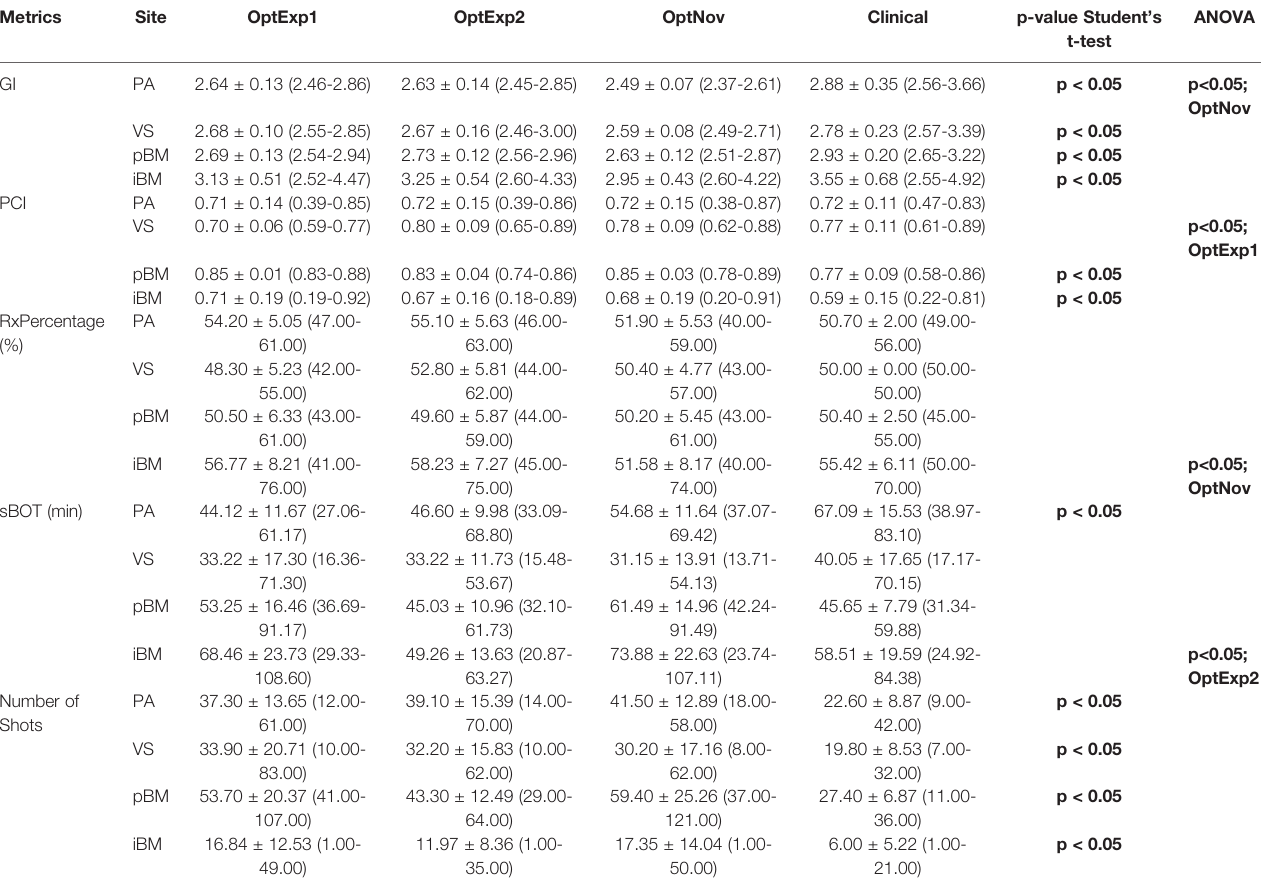
TABLE 1 | Summary of the target metrics among the inversely optimized and clinical plans for all sites.